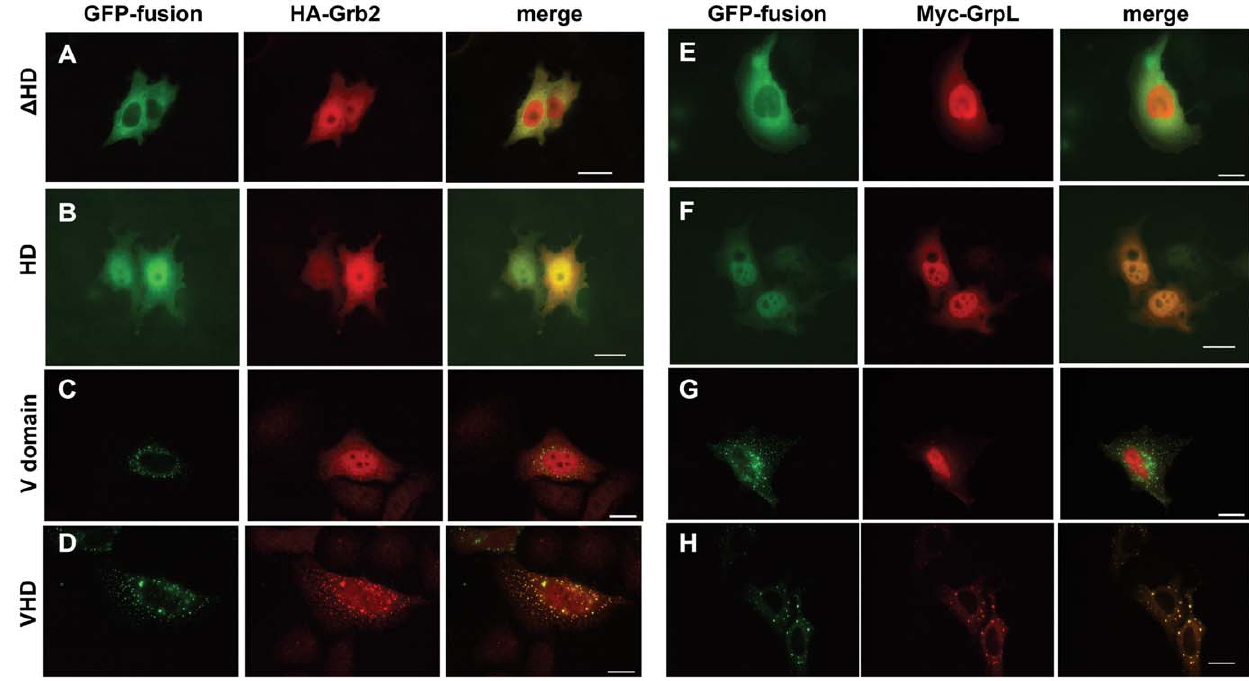
Figure 6. Histidine Domain is required for the co-localization of HD-PTP with HA-Grb2 or Myc-GrpL. HeLa cells were transfected with plasmids expressing EGFP-tagged HD-PTP proteins [ D HD (A and E), HD (B and F), V-domain (C and G), or VHD (D and H)] and either HA-Grb2 (A–D) or Myc-GrpL (E-H). 18–24 h post-transfection, the cells were fixed, permeabilized and incubated with anti-Myc or anti-HA antibodies, followed by incubation with secondary antibodies labeled with AlexaFluor 594. Mounted coverslips were imaged with a fluorescence microscope. Scale bars, 20 m m.